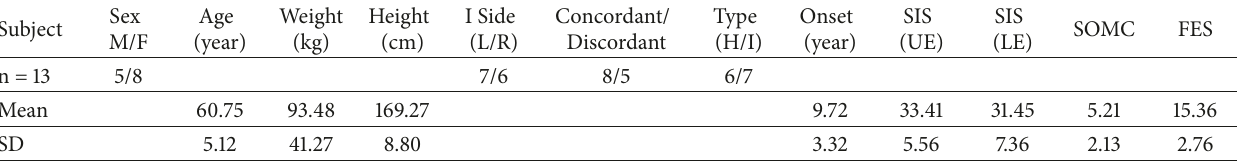
Table 1: Demographics and stroke characteristics of community-dwelling stroke participants are shown in the table.